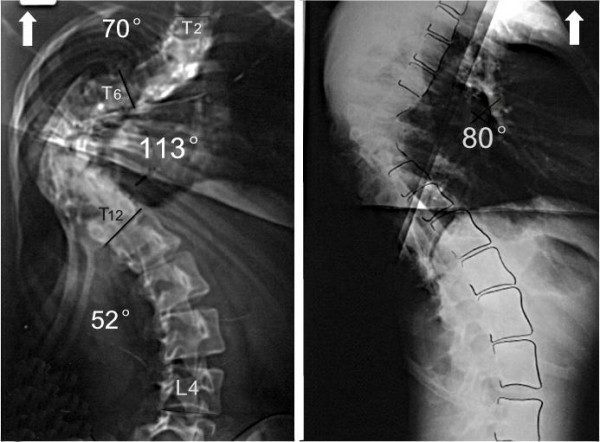
Suspension view shows the flexibility of spine.